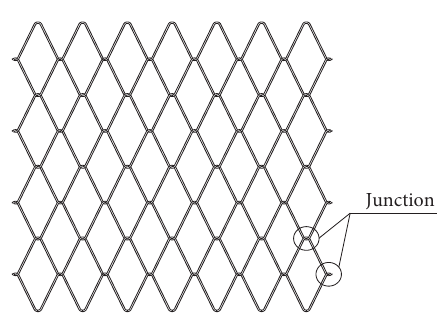
Figure 5: Schematic diagram of the metal flexible